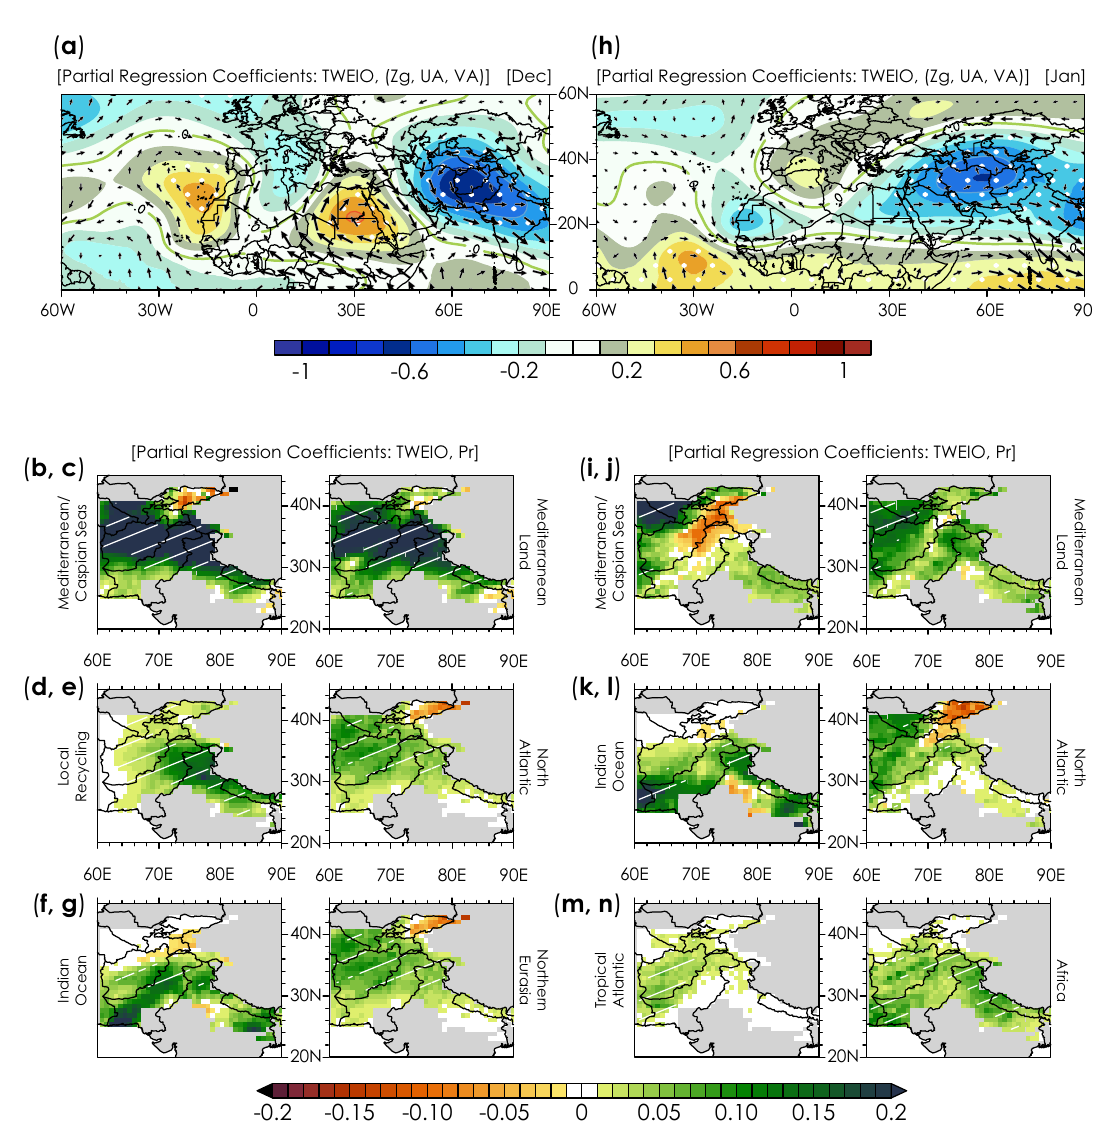
Fig. 5 Standardized partial regression coef fi cients associated with the TWEIO in the multi-linear regression models. Standardized partial regression coef fi cients of 200 mb geopotential height, zonal and meridional winds ( a ), and regionally recycled precipitation ( b – g ) on the TWEIO index for December. Six selected evaporative source regions exhibit the most prominent statistically signi fi cant relationship. ( h – n ) Same as in ( a – g ) but for January. Standardization of regionally recycled precipitation is with respect to the total recycled precipitation. Stippling represents statistical signi fi cance at a 90% con fi dence